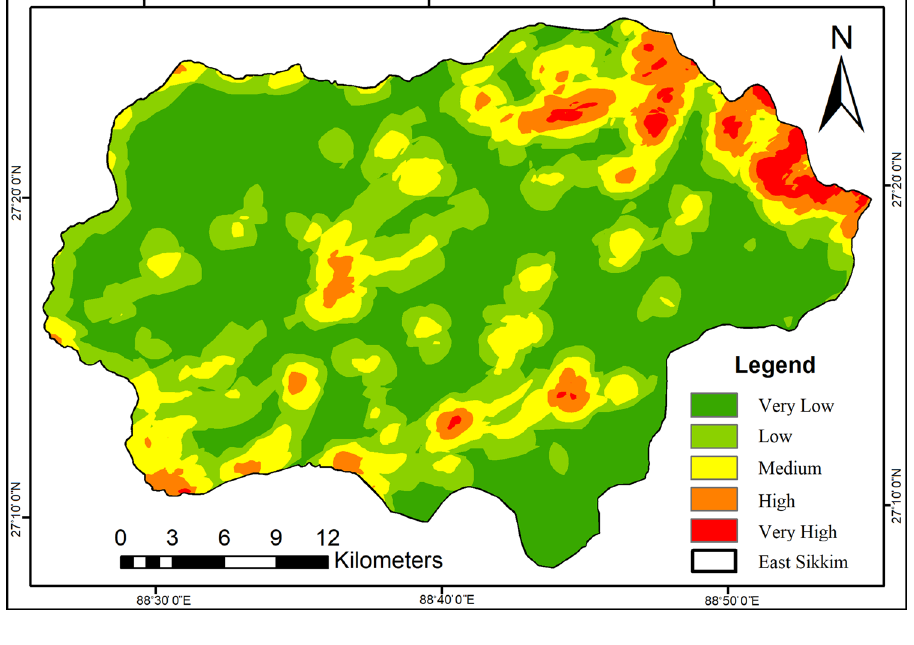
Fig. 10 Lineament density map of East Sikkim